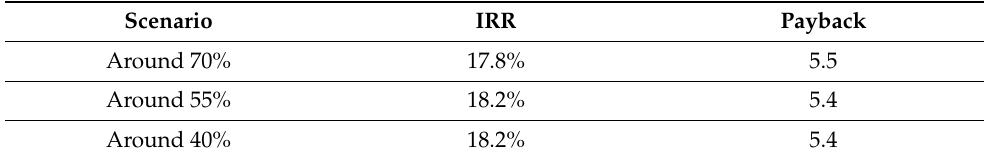
Table 17. Indicators IRR and payback from three scenarios.